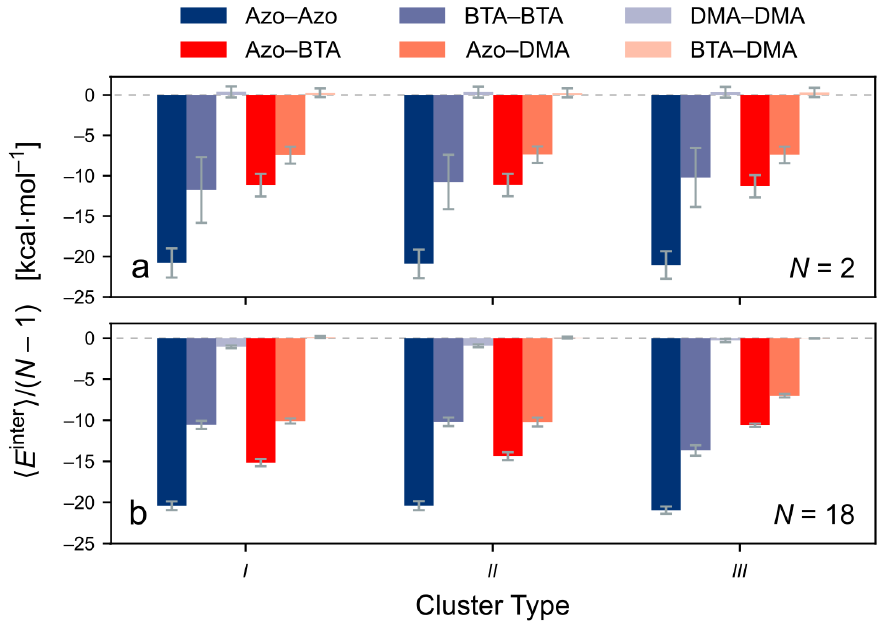
Figure 10. Decomposition of the intermolecular energy of the clusters into contributions due to interactions between the various physical parts of the TrisAzo molecules. The energies are divided by the number of neighboring monomer pairs ( N − 1) for better comparability. Results for ( a ) N = 2 and ( b ) N = 18 are shown for each cluster